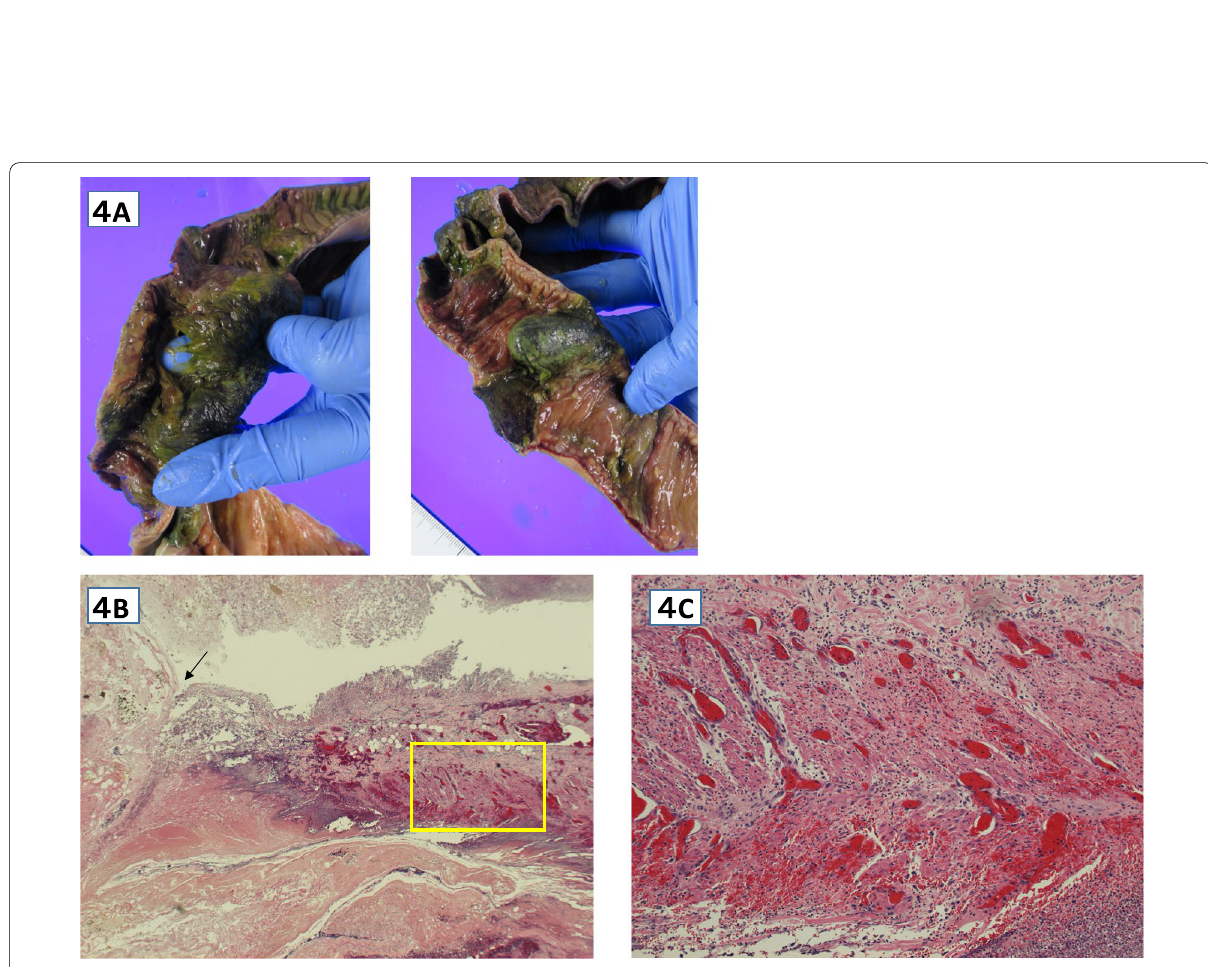
Fig. 4 A – C : Pathological findings: A Multiple intestinal necrosis and perforation are observed in the ileum. B , C Frequent thrombi from the small intestinal mucosa around the perforation ( ) to the muscularis propria (HE staining 20). C The muscular layer ( □ ) in Fig. 4B is enlarged, thrombi → × that frequently occur in the muscularis peculiar to the small intestine around the perforation can be confirmed. (HE stain ×